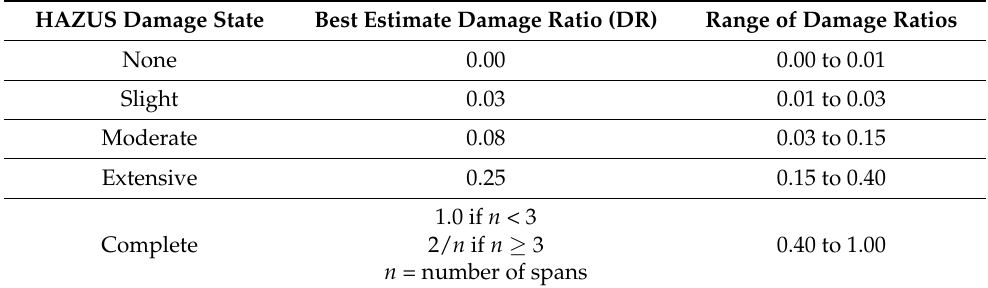
Table 2. Variation of damage ratios defined by HAZUS (slightly modified after HAZUS